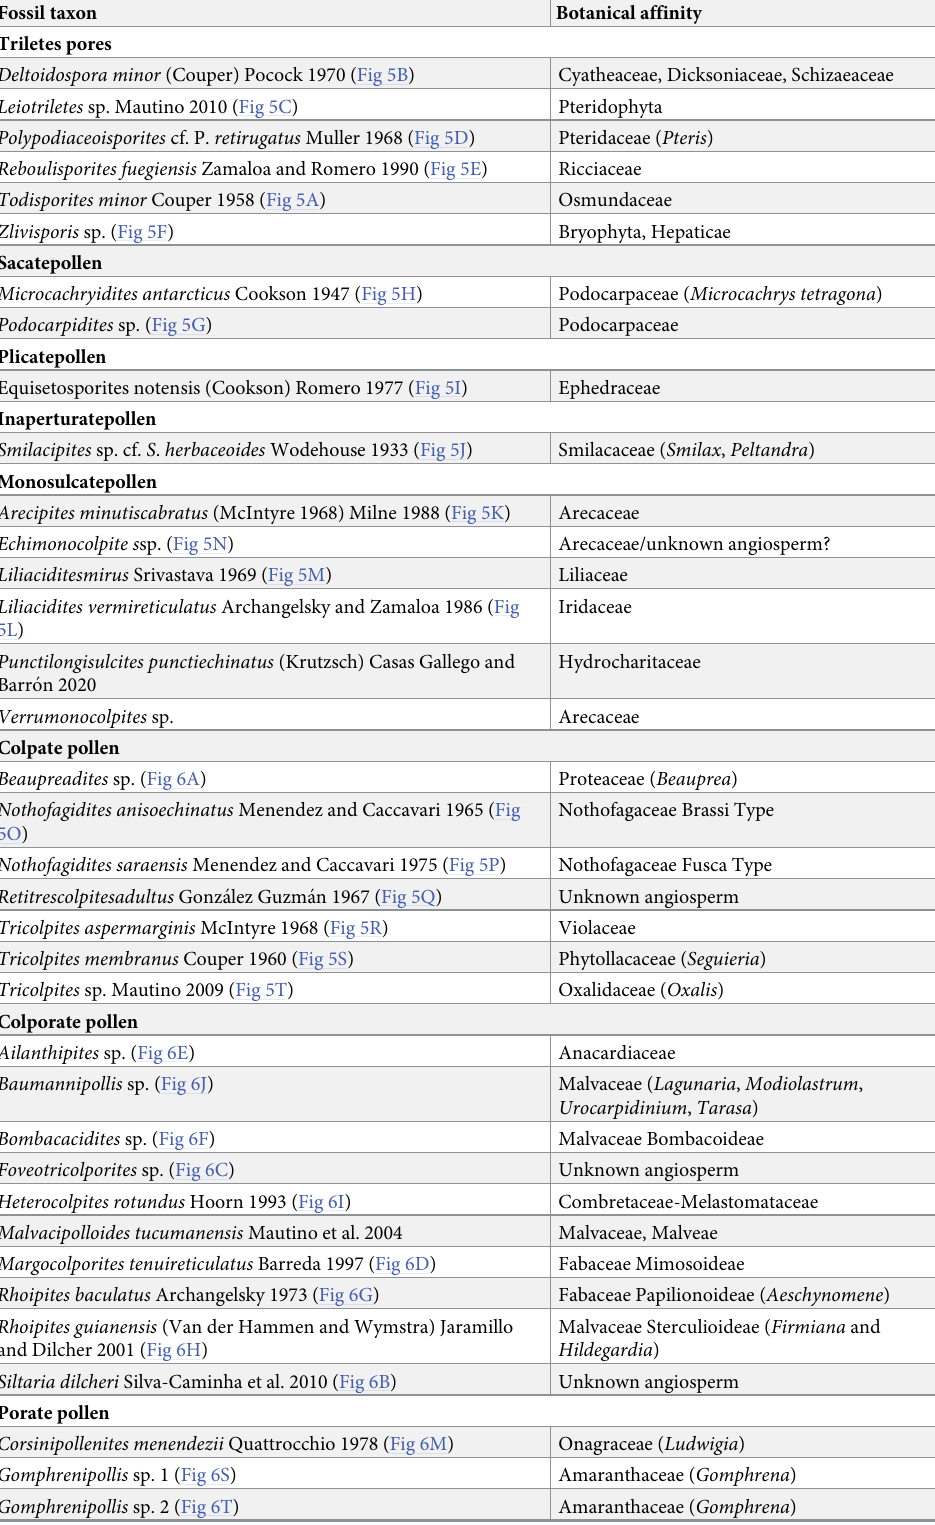
Table 1. Identified morphotype